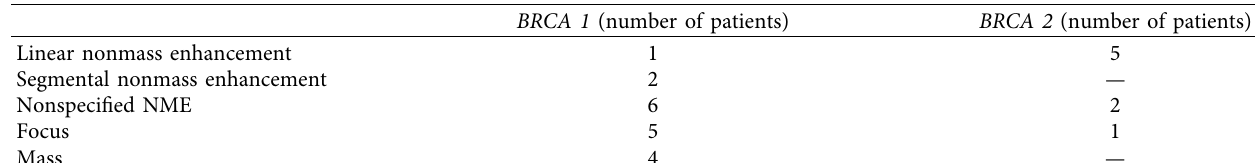
Table 2: MRI imaging findings.